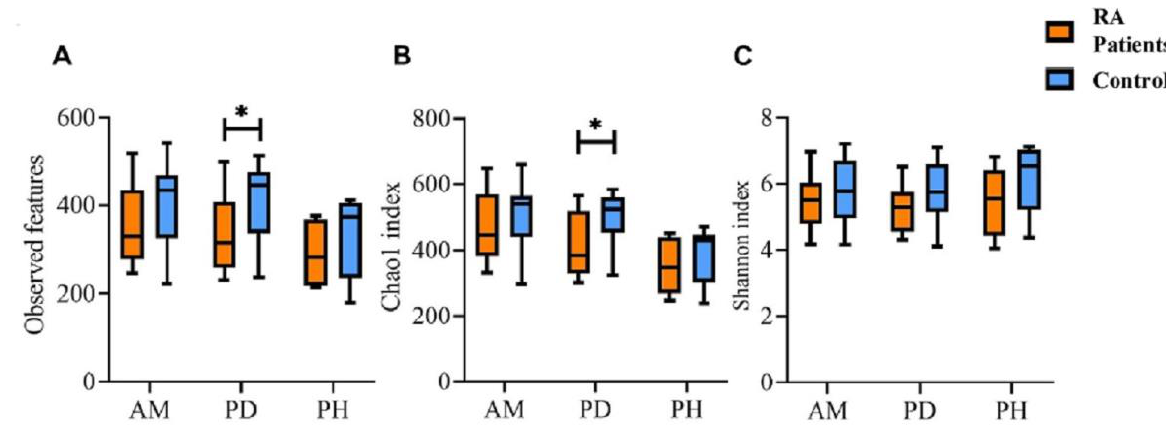
Figure 2. The intra-group diversity of subgingival microbiota in groups AM, PD, and PH. ( A ) The number of the observed bacterial features, ( B ) Chao1 index, and ( C ) Shannon index. The RA patients are indicated in orange, and the controls are indicated in blue. The data are expressed as median (25th, 75th percentile). *, p < 0.05.